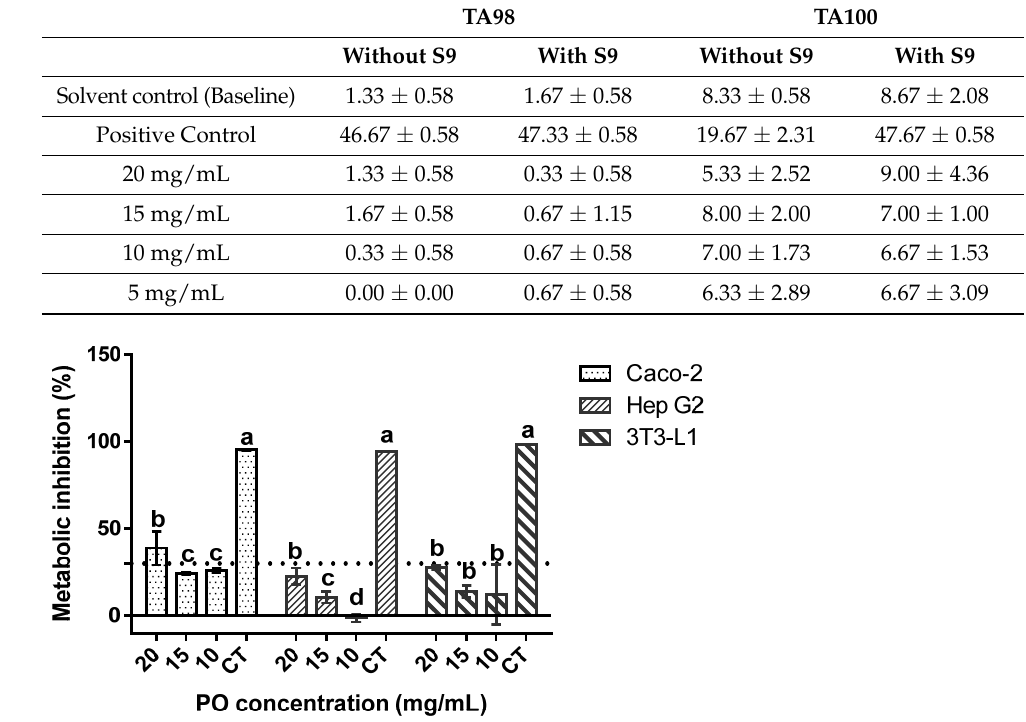
Table 3. Results obtained for PO samples AMES genotoxicity assay against S. typhymurium TA98 and TA100. All values represent the average number of positive (revertant) wells ± standard deviation.